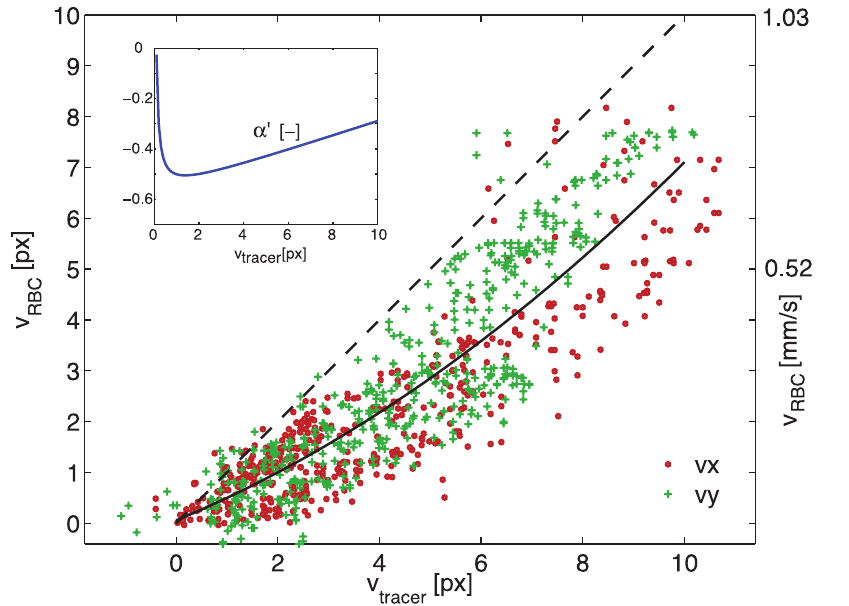
Figure 6. Agreement at M ~ 25 | . A scatterplot of the displacement measured using red blood cells versus the results using tracers. Data of the first three time steps are shown in one figure; horizontal and vertical components are shown separately ( : and + , respectively). The dashed line indicates perfect agreement, the solid line is a quadratic fit. The inset shows the relative underestimation a 0 based on the polynomial fit.